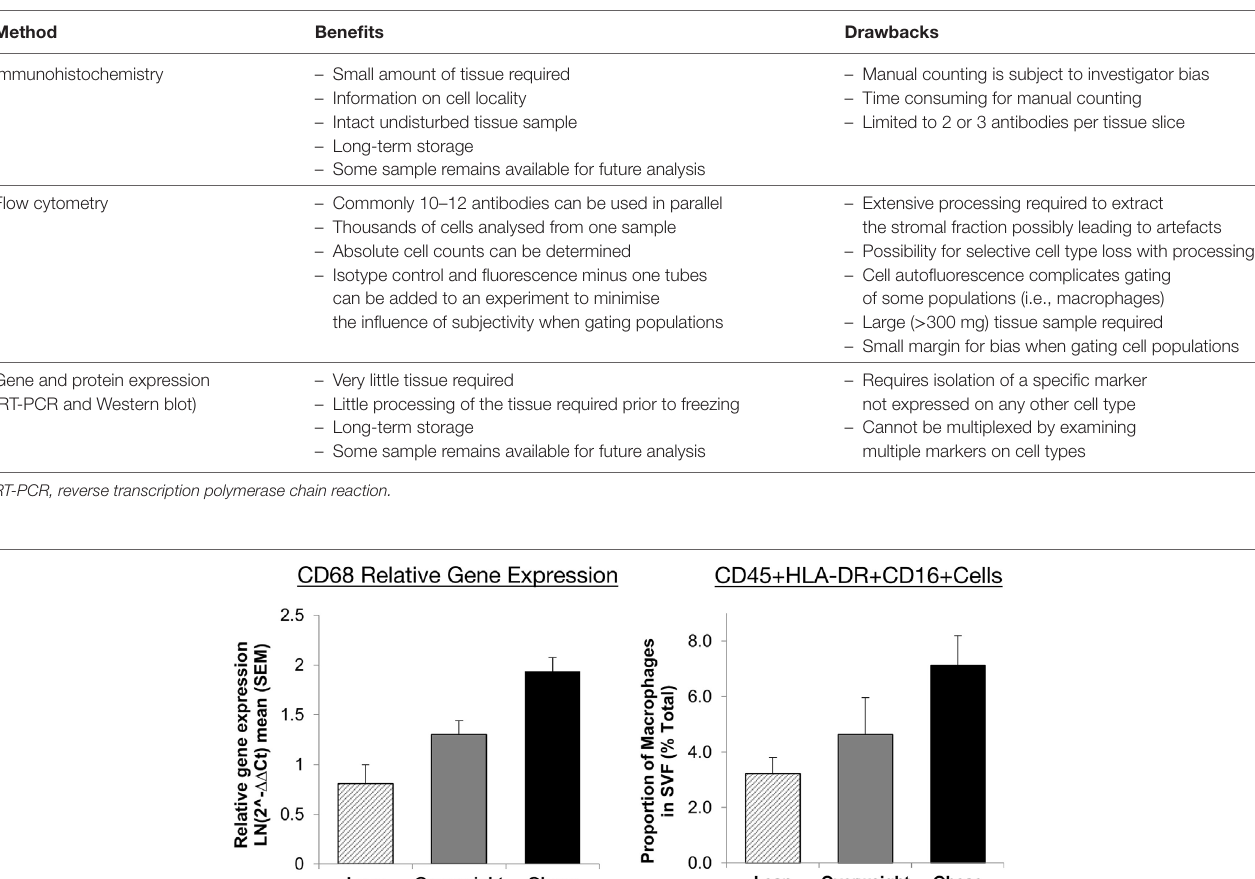
TABLe 1 | Appraisal of three commonly utilised methods of assessing the cells of the adipose tissue stromal